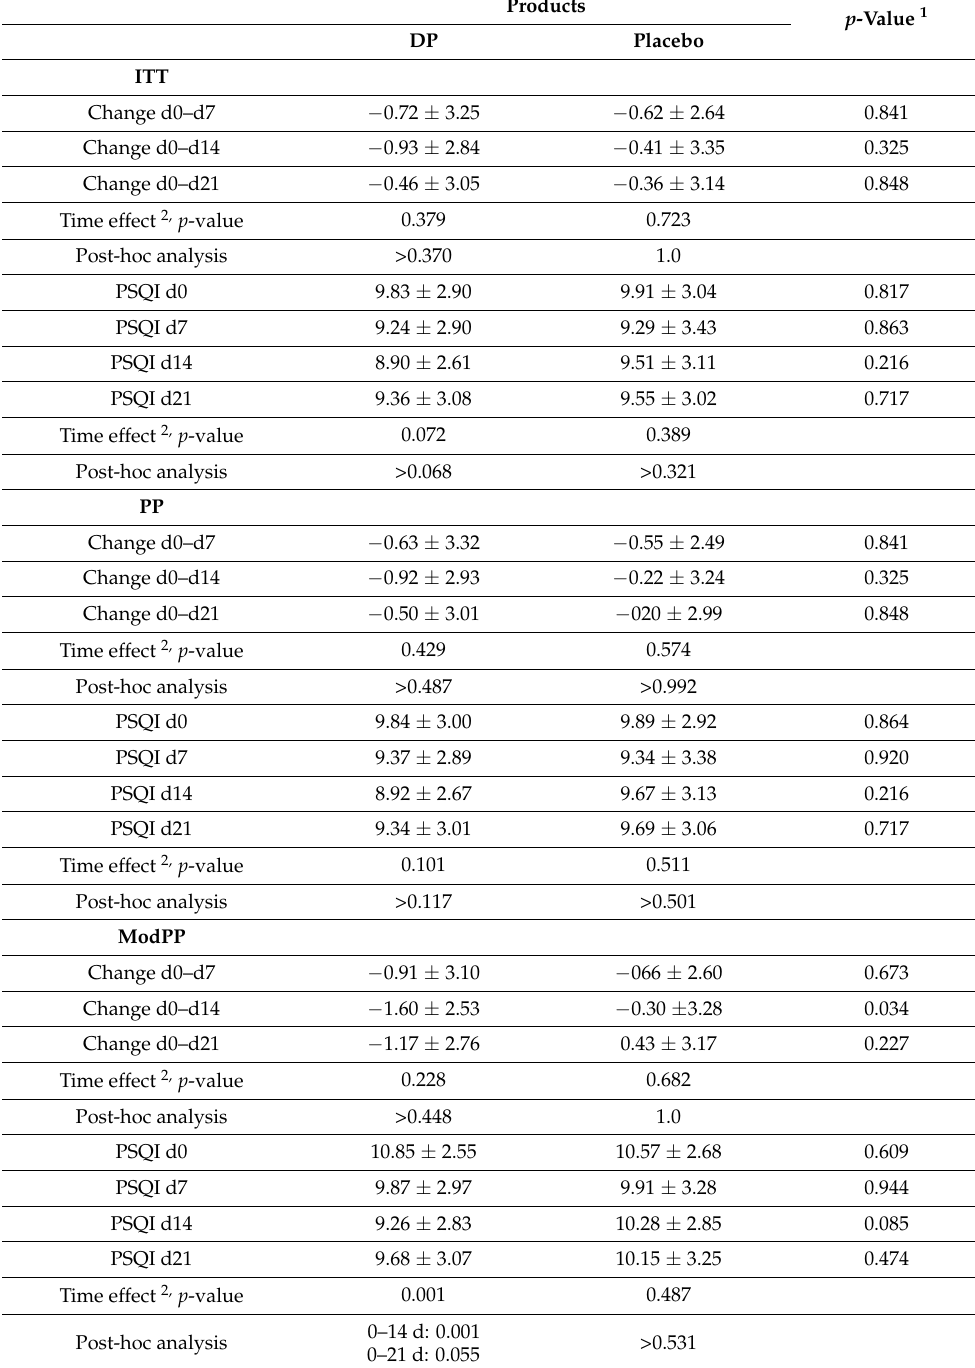
Table 3. Changes in delta-PSQI and absolute PSQI between and within product groups, taking intervention periods 1 and 2